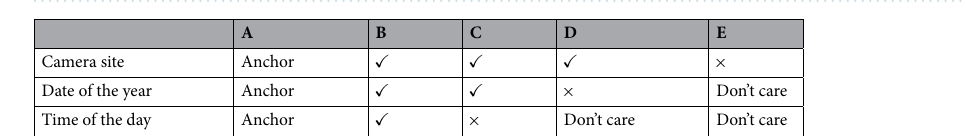
Table 3. Similarity between the anchor sample and all other samples in the sequence is determined based on the camera site, date, and time of the day, in that order. A (cid:31) indicates that the sample is similar to the anchor for the considered factor, whereas an × indicates that the two samples